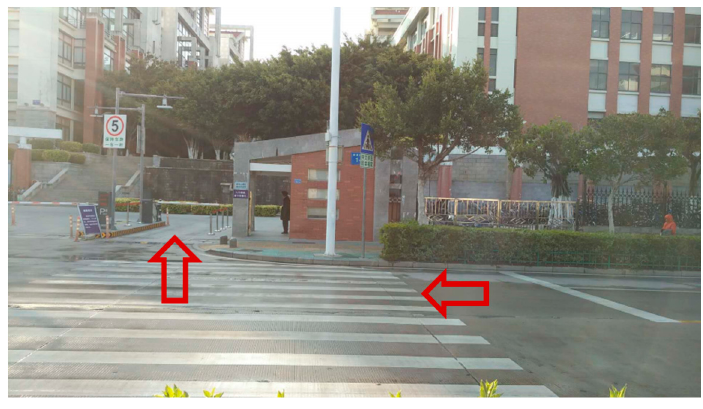
Figure 7. Scene 2—school gate.